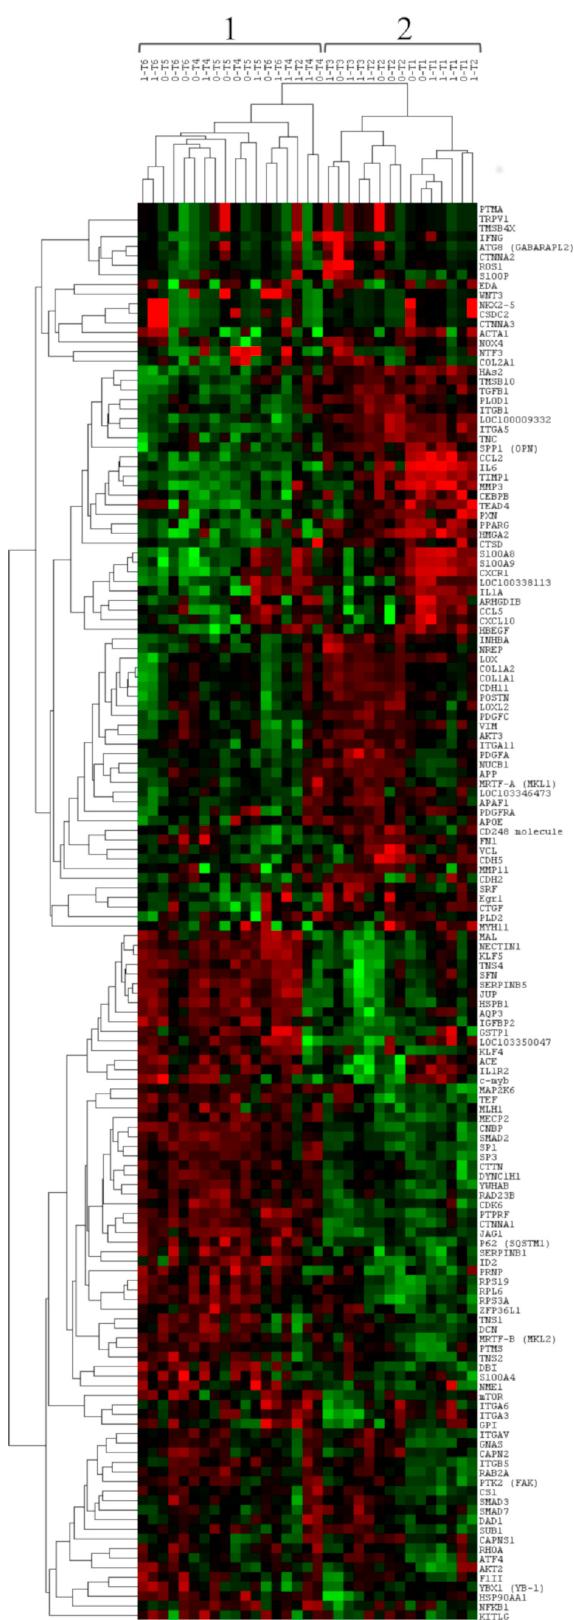
Figure 2. Unsupervised hierarchical clustering analysis of post-extractive sockets using the 148 genes of the custom panel. The two main clusters are indicated with numbers 1 and